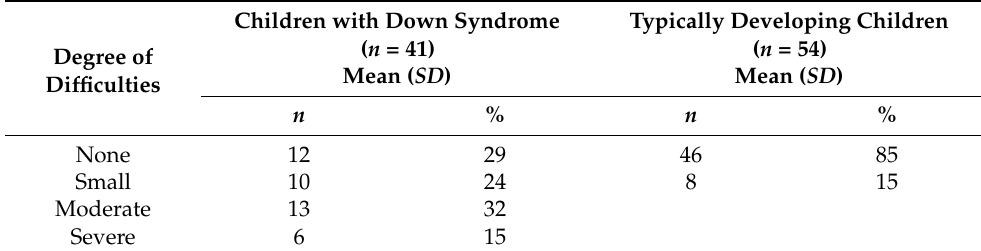
Table 2. Degree of difficulties with fluency among children with Down syndrome and typically developing children at the same non-verbal mental age level.